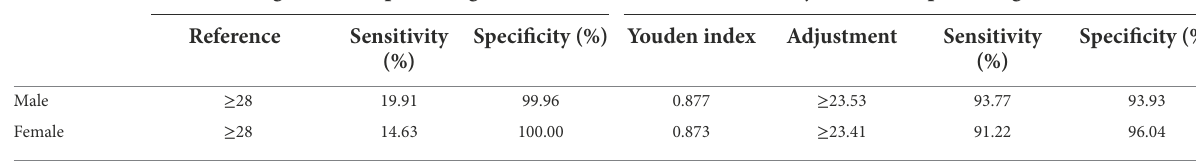
TABLE 5 Sensitivity and specificity of original and adjusted BMI cutoff